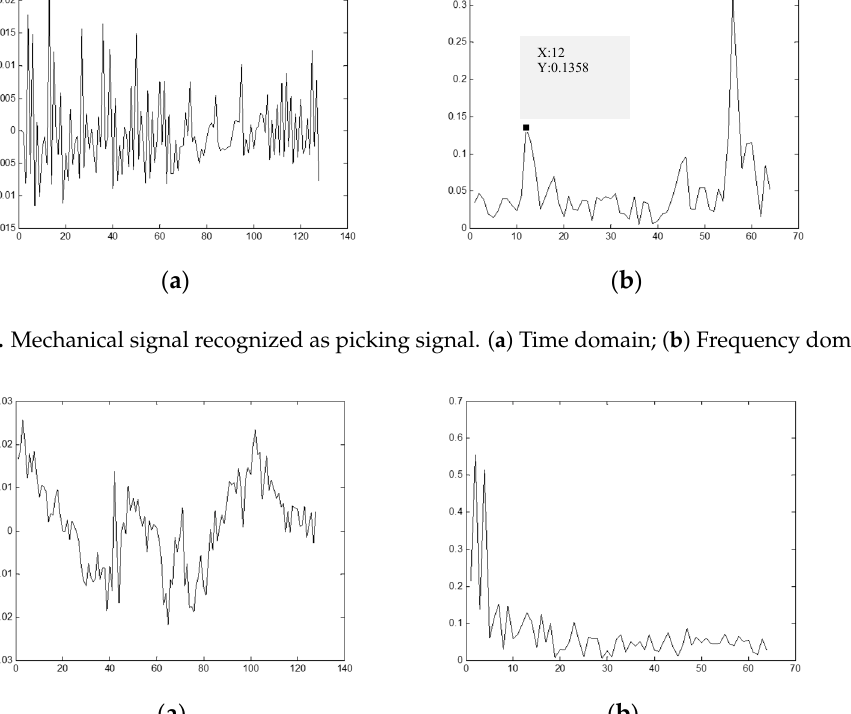
Table 2. The identification rate of Mechanical signals.